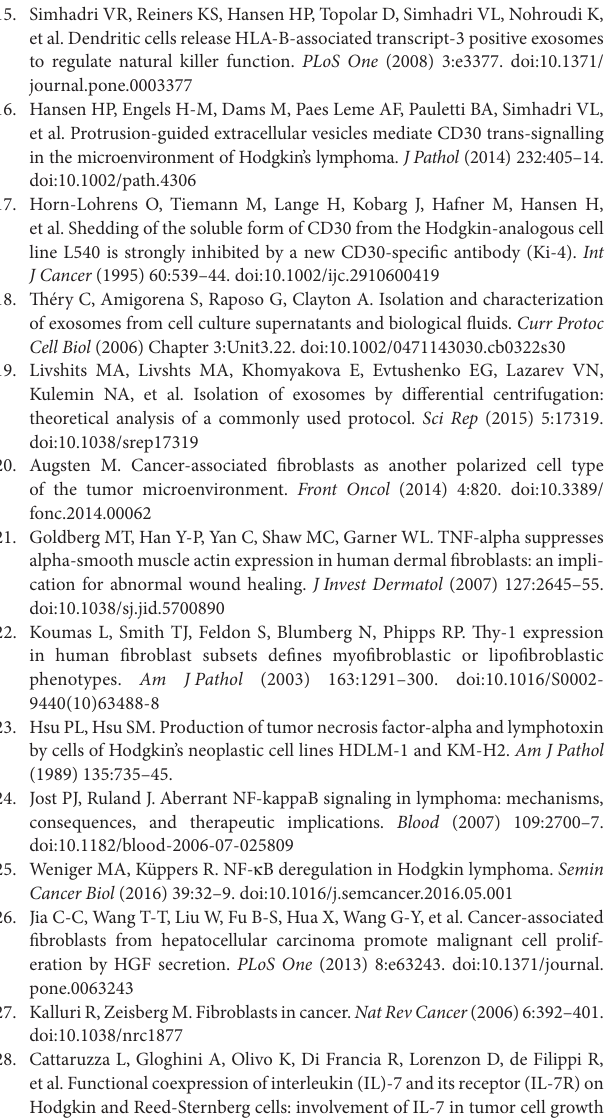
FigUre s1 | (a) Representative histograms of flow cytometric analysis of exosome markers (B) as well as phosphatidylserine and the Hodgkin lymphoma (HL) marker CD30 on HL-derived extracellular vesicles (EVs) (line) compared to isotype control (solid blot). The in (a,B) presented FACS analysis was performed in three independent experiments. (c) Flow cytometric evaluation of HL cells stained with 0.25 or 1 µm DiO compared to unstained cells (Ctrl). (D) EV-uptake in fibroblasts cells studied via IF: cytoplasm was stained with cell mask deep red (red), nuclei with Hoechst and HL-derived EVs with DiO (green). Depicted are three representative pictures from upper, middle, and bottom section of a fibroblast. FigUre s2 | (a) Representative bright field and fluorescence pictures of a scratch assay after 24 h exposure of fibroblasts to 100 µg/ml Hodgkin lymphoma (HL) extracellular vesicles (EVs), medium or 5 ng/ml TGF- β as a positive control. Nuclei are depicted in blue and abundance of α -SMA in green. Microscopic assessment of α -SMA was performed for all three independent scratch assays summarized in Figure 2B . (B) Statistical evaluation of the Human 64-Plex Chemokine Array. Abundance of chemokines/cytokines after 24 h in the supernatant of fibroblasts under influence of HL EVs compared to cells incubated with normal medium (white bars: decrease, black bars: increase). Statistical